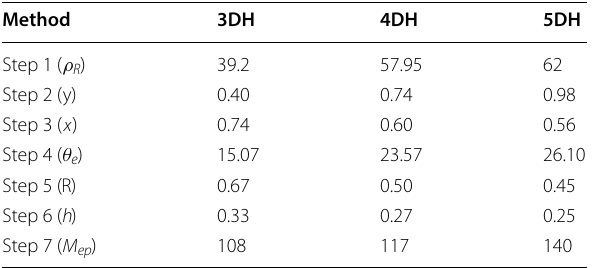
Table 4 Seven-steps enable an estimate of the extent of plasticity within the equivalent bend radius of a hooked end